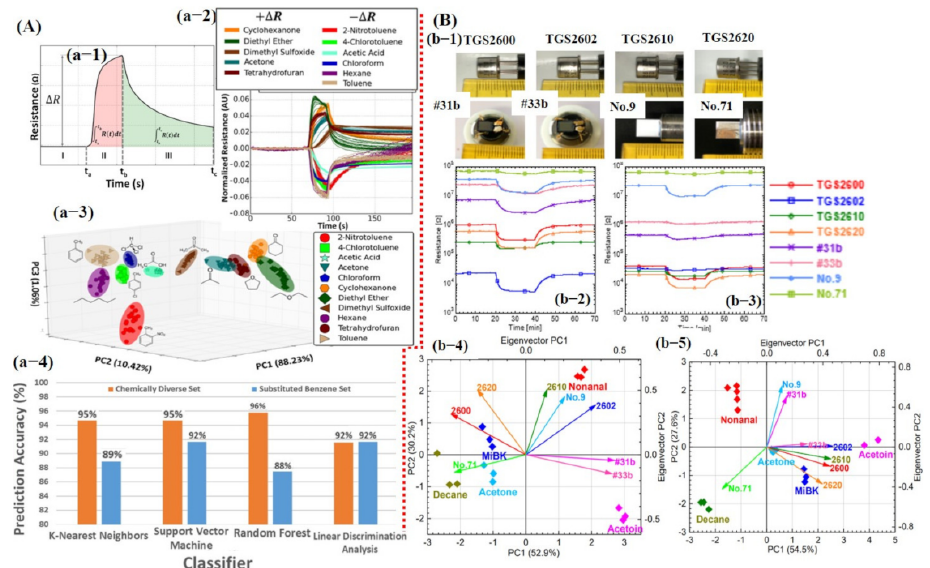
Figure 13. Smart sensing using machine learning: ( A ) Sensing of several compounds using single graphene-based chemiresistive sensor: (a-1) Typical response of chemiresistive sensor, regions I, baseline; II response time; and III, recovery. It indicates the potential features that can be extracted including the maximum change in resistance ( ∆ R), area of the response (red shaded area), and area of the recovery (green shaded area). (a-2) Normalized response for all compounds, ready for feature extraction. (a-3) PCA scores for the 11 compounds revealed small overlapping. (a-4) Different classifier prediction accuracy histogram, reproduced with permission from [123], copyright 2016 ACS. ( B ) e-nose system for smart detection of different compounds under dry and humid air: (b-1) Optical image for all the sensors. (b-2,3) Sensor response under dry and humid air, respectively. No. 9 and no. 71 sensors were not affected by humidity. (b-4,5) Corresponding PCA results of all sensor data in air and humid environment; PCA also confirmed the little humidity effect on no. 9 and no. 71 sensors. Reproduced with permission from [130], copyright 2017